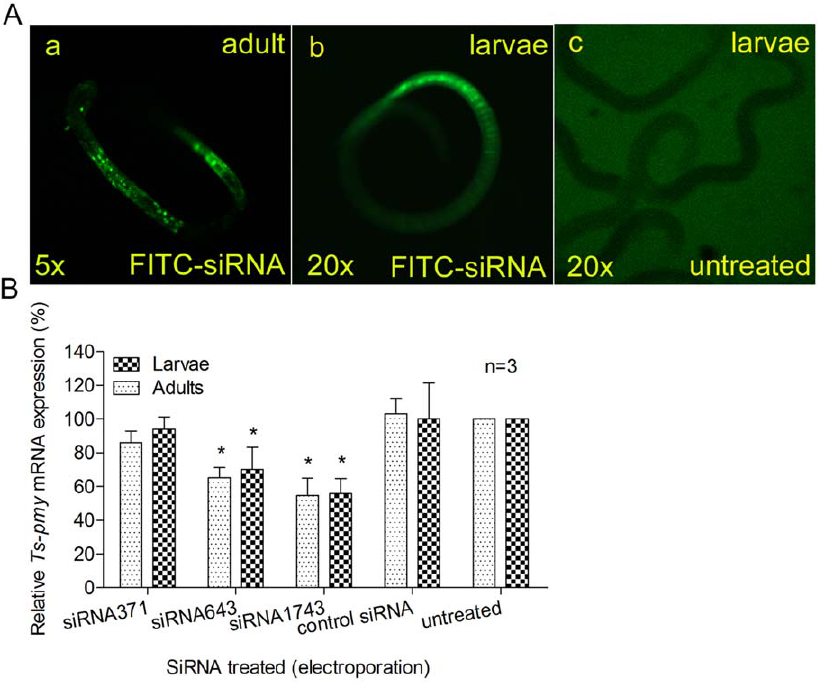
Figure 1. The silencing of Ts-pmy mRNA mediated by siRNA. The adult and larval T. spiralis were transfected with FITC-labeled control siRNA by electroporation (A). Uptake of FITC-labeled siRNA into adult worms (a) and larvae (b) 18 hours after electroporation under a fluorescent microscope. No fluorescence was observed in the untreated group (c). The relative levels of Ts-pmy mRNA in parasites (larvae and adults) 6 days after being electroporated with different siRNAs, as determined with qRT-PCR (B). All of the assays were performed in triplicate, and the data are presented as the mean 6 SE. * p , 0.05 compared with control siRNA.